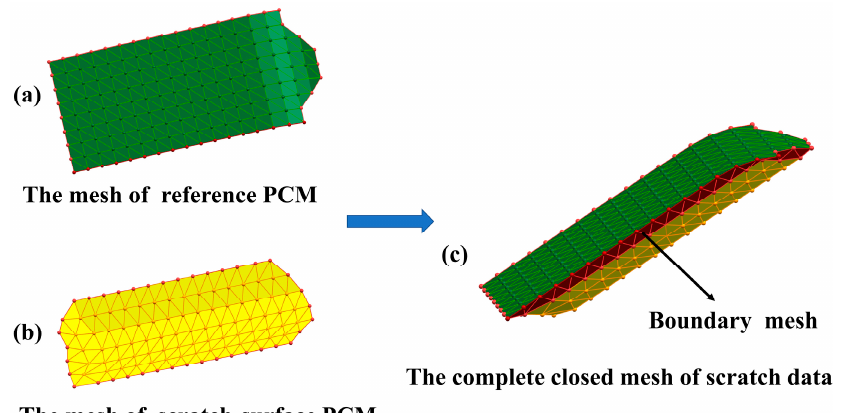
Figure 13. The process of constructing the complete closed mesh model of scratch data. ( a ) The mesh of reference PCM; ( b ) The mesh of scratch-surface PCM; ( c ) The complete closed mesh model of scratch data stitched by ( a ) and ( b ) through the boundary mesh.